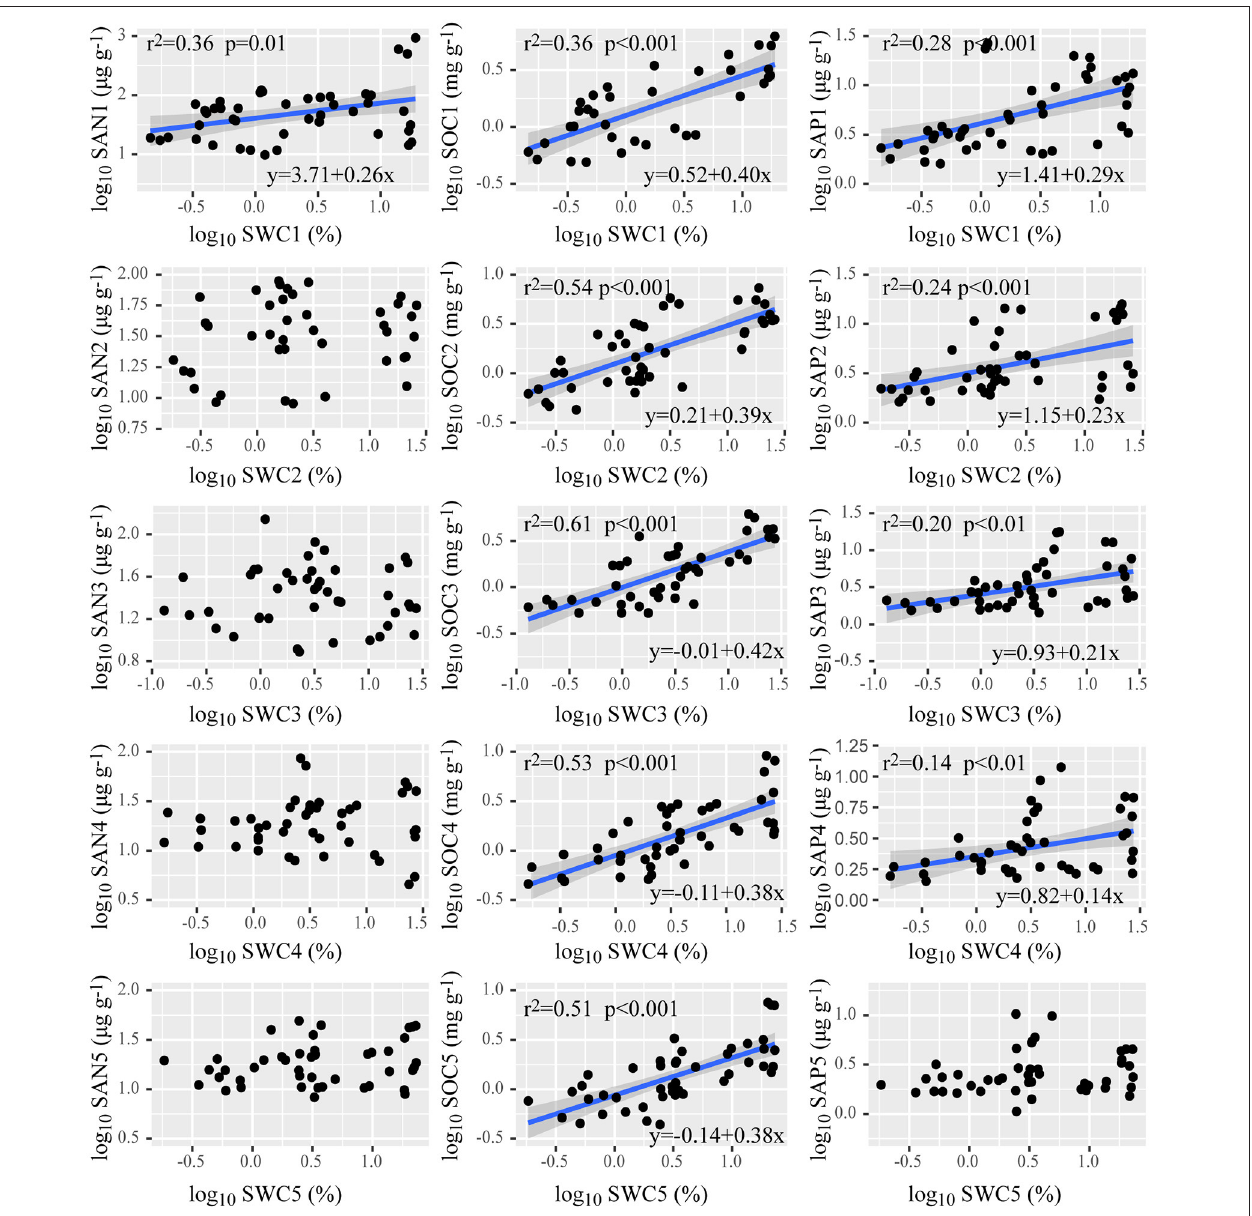
FIGURE 3 | Relationships of soil water content with the available nutrients in the soil at depths of 0–20, 20–40, 40–60, 60–80, and 80–100cm. SAN1–5 is soil alkali hydrolyzable nitrogen at 0–20, 20–40, 40–60, 60–80, 80–100cm depths; likewise, for SOC1–5, soil organic carbon; SAP1–5, soil available phosphorus; SWC1–5, soil water content. Regression lines (blue lines) are shown only for relationships that were significant at p < 0.05. Shaded bands around each line represent the 95% confidence interval for the linear